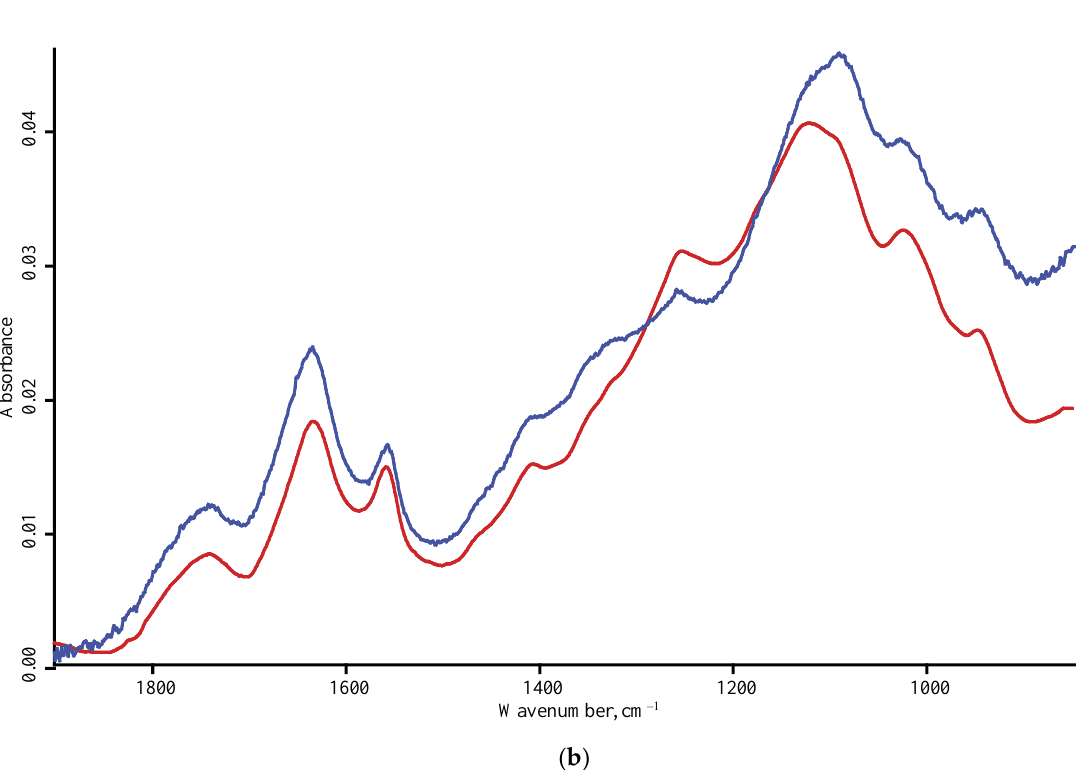
Figure 9. ATR mode, UDA-SP nanodiamonds; red, LN-MCT photovoltaic detector; blue, DLaTGS detector ( a ) 4000–2500 cm −1 , ( b ) 2000–800 cm −1 range. Spectra are not smoothed but normalized to maximize each spectrum.